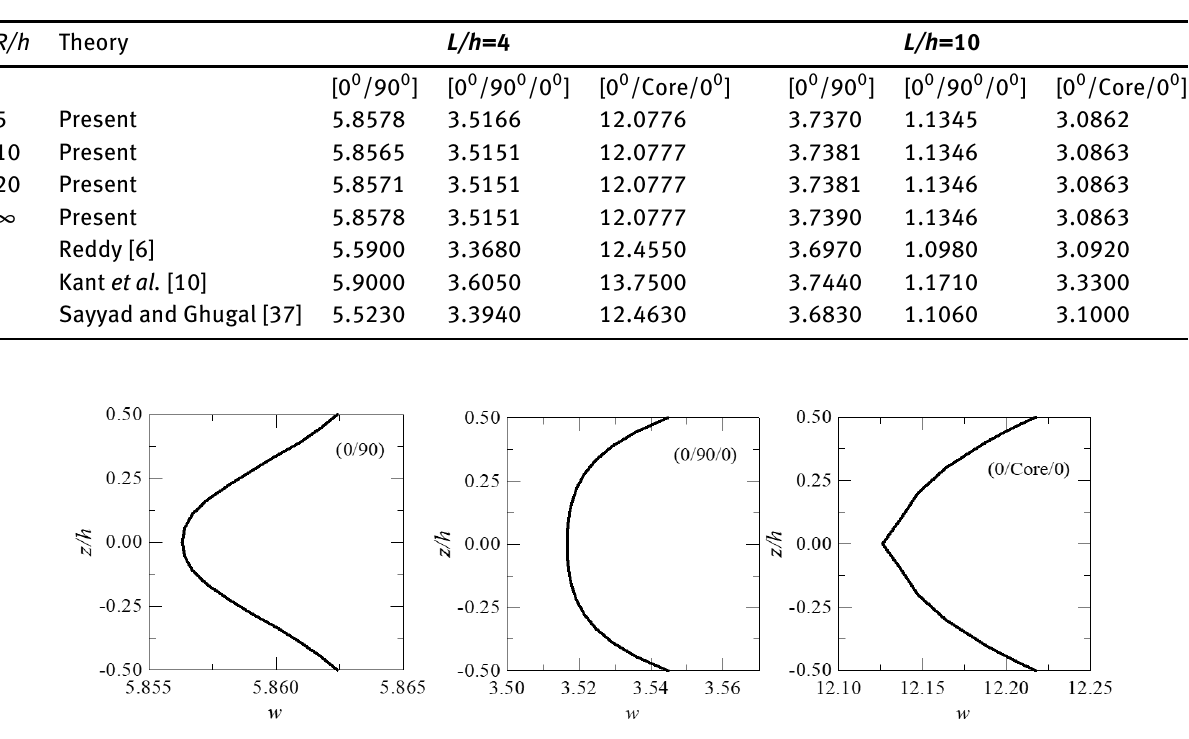
Figure 2: Through-the-thickness variations of vertical displacement for laminated and sandwich beams curved in elevation ( L/h= 4, R/h= 5).